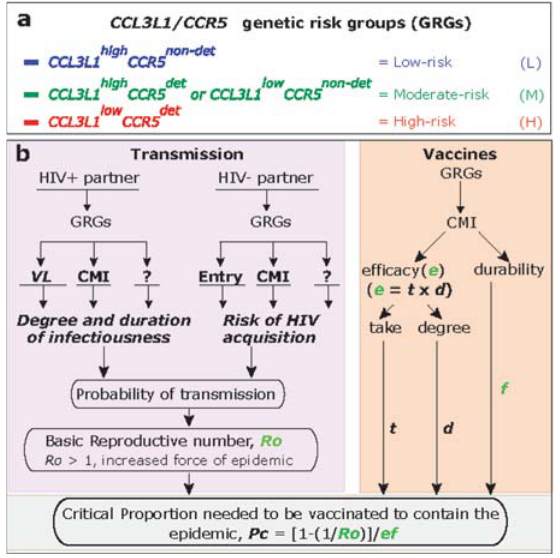
Figure 1. Conceptual model by which CCL3L1-CCR5 genotypes might influence the prevention and epidemic outgrowth of HIV infection. ( a ) Classification system used to categorize the copy number of CCL3L1 (low or high) and genotypes of CCR5 (detrimental